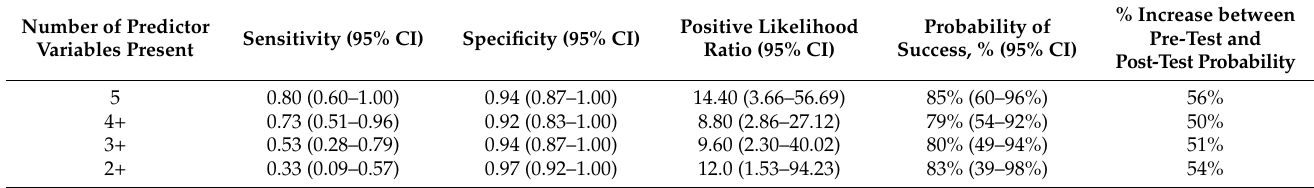
Table 3. Accuracy for the five levels of the clinical prediction rule *.